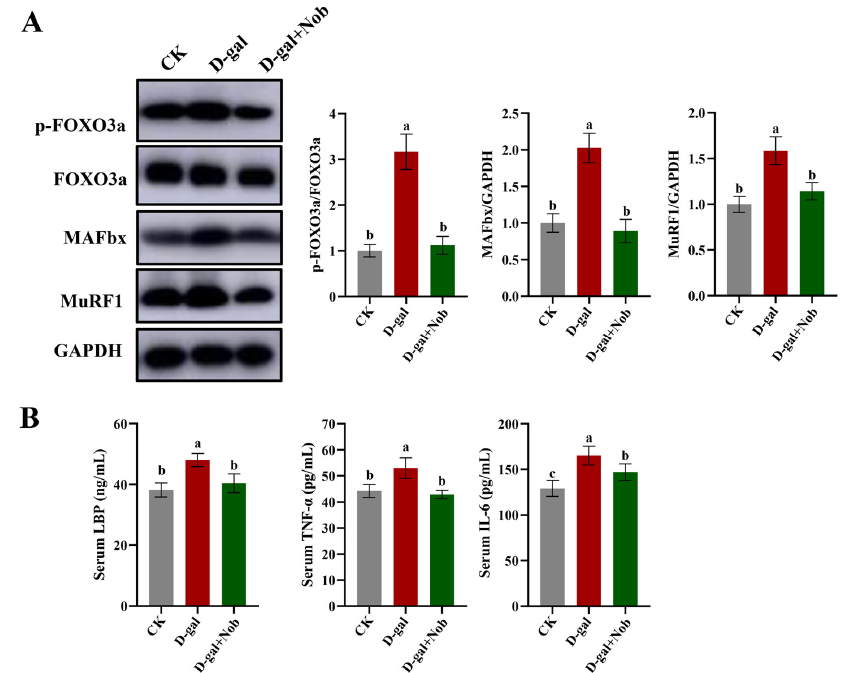
Figure 5. Nob-inhibited skeletal muscle protein degradation in D-gal-induced aging mice. ( A ) West- ern blot analysis of FoxO 3a, p-FoxO 3a, MAFbx, MuRF1, and GAPDH in the CK, D-gal and D-gal + Nob groups, n = 3. ( B ) Inflammation markers including LBP, TNF- α , and 1L-6 in the CK, D-gal and D-gal + Nob groups, n = 8. Significant differences between treatment groups are represented by the lowercase le tt ers a, b, and c ( p < 0.05).